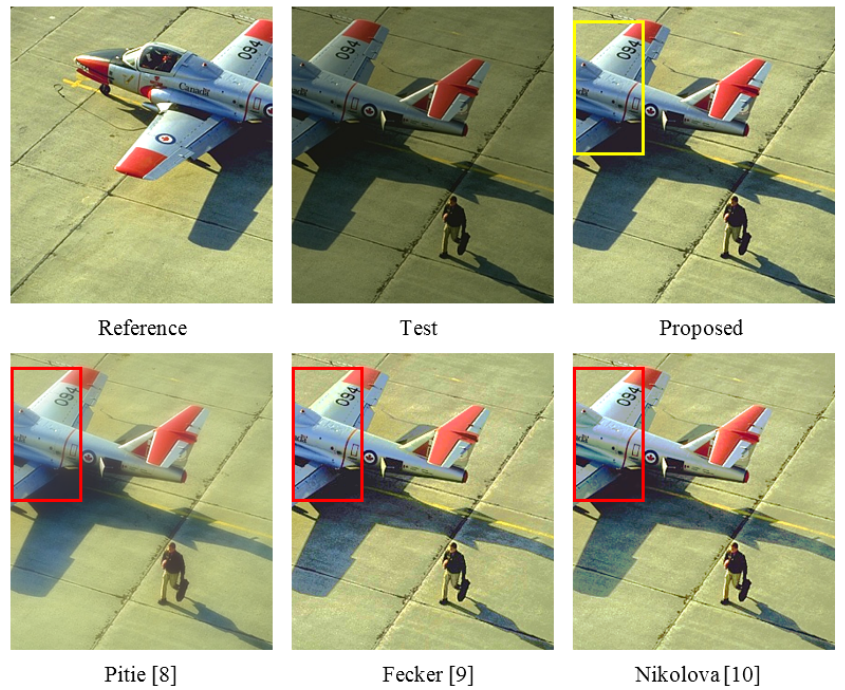
Figure 6. Comparison for the synthetic image pair. Image Source: courtesy of the authors and databases referred on